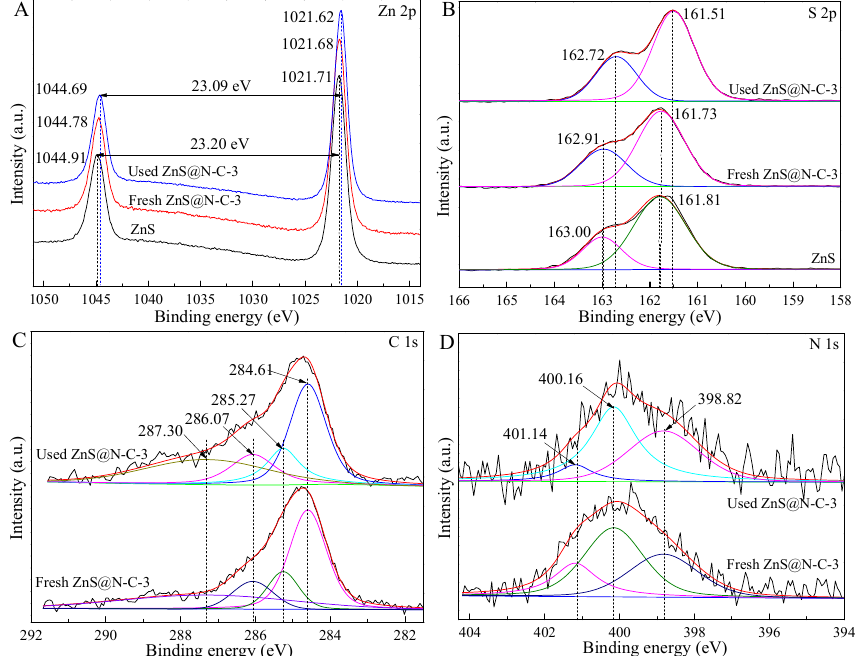
Figure 6. Zn 2p ( A ), S 2p ( B ), C 1s ( C ), and N 1s ( D ) XPS spectra of ZnS and fresh and used ZnS@N-C-3.